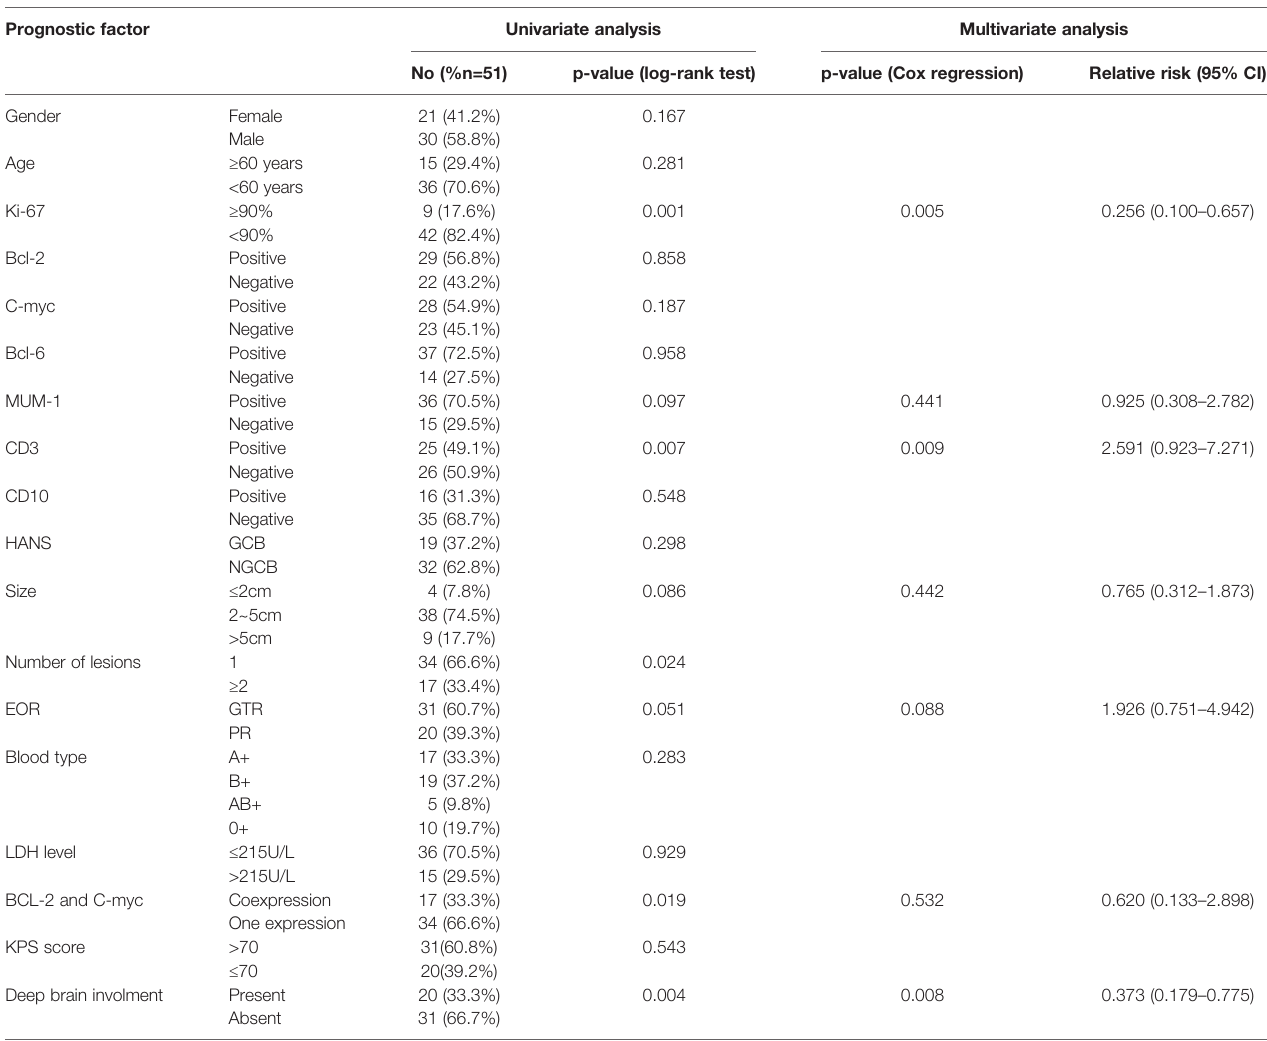
TABLE 4 | Univariate and multivariate analyses of risk factors for progression-free survival. Prognostic factor